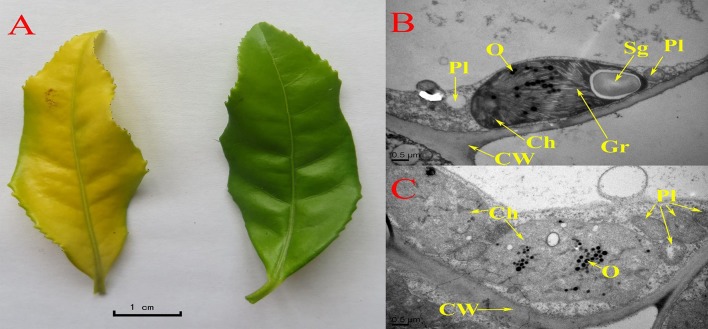
Phenotypic and ultra-structural characterization of chlorotic and green leaves. (A) Chlorotic leaves (left) and non-chlorotic leaves (right). (B,C) Ultrastructure of non-chlorotic leaves (B), and chlorotic leaves (C). Ch, chloroplast; CW, cell wall; Gr, grana; O, osmiophilic granules; pl, plastid; Sg, starch granule.